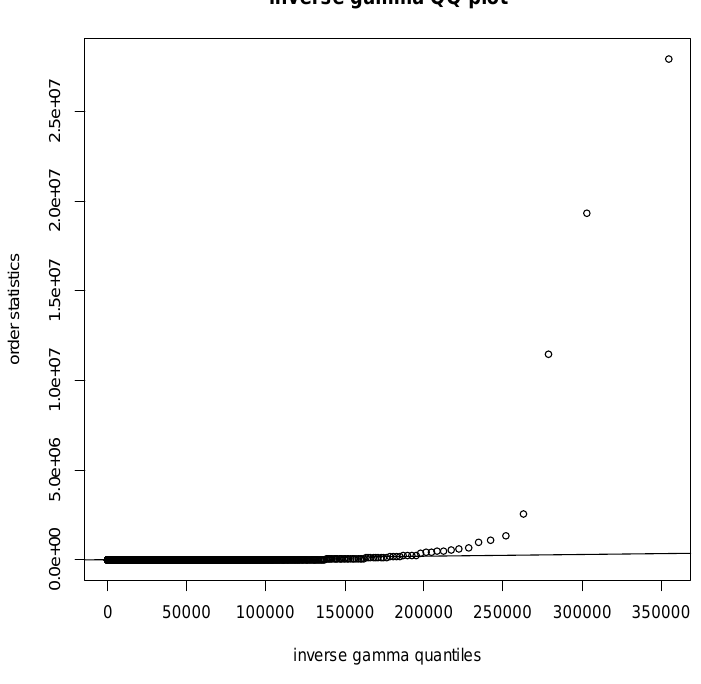
Figure 1 – Inverse gamma Q-Q plot of 30-day historical volatilities 5,671 stocks, period ending 16 Nov